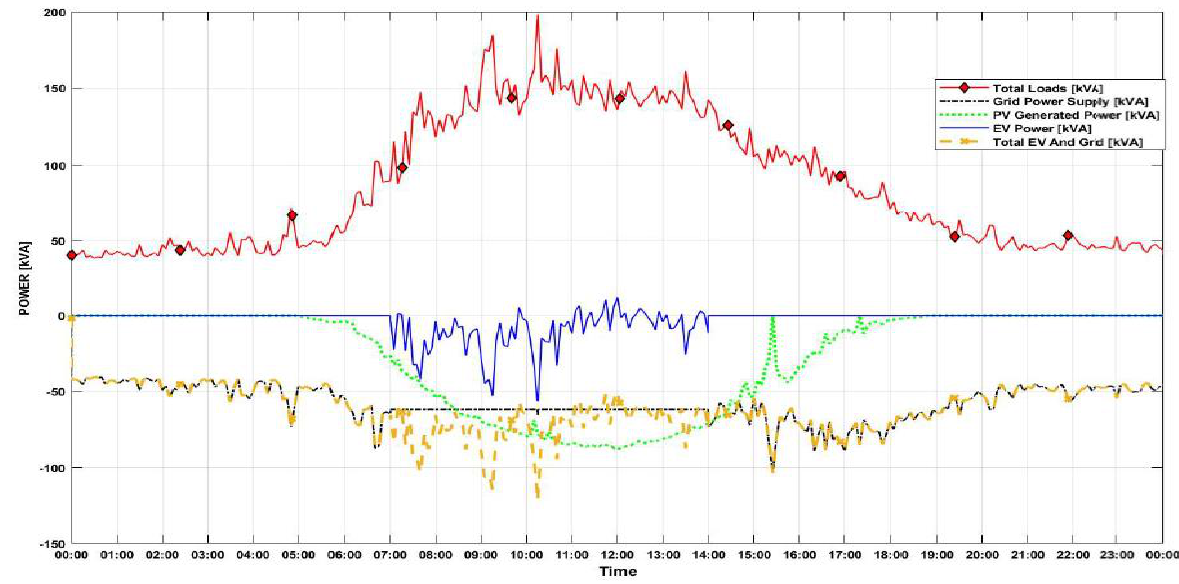
Figure 26. The behavior of MCAST micro-grid integrated with electric vehicles.